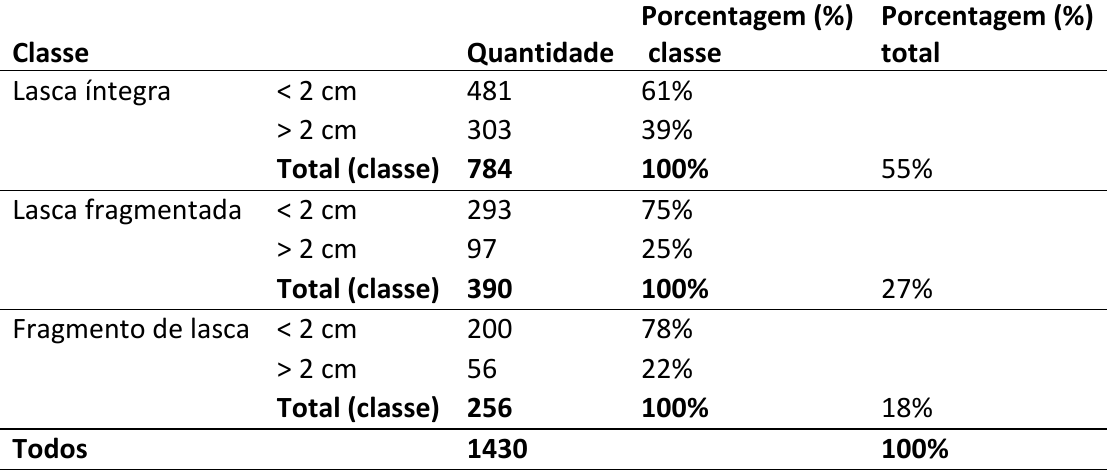
Tabela 4. Classes gerais identificadas no Sítio Abrigo de Itapeva. Table 4. General identified categories from the Abrigo de Itapeva